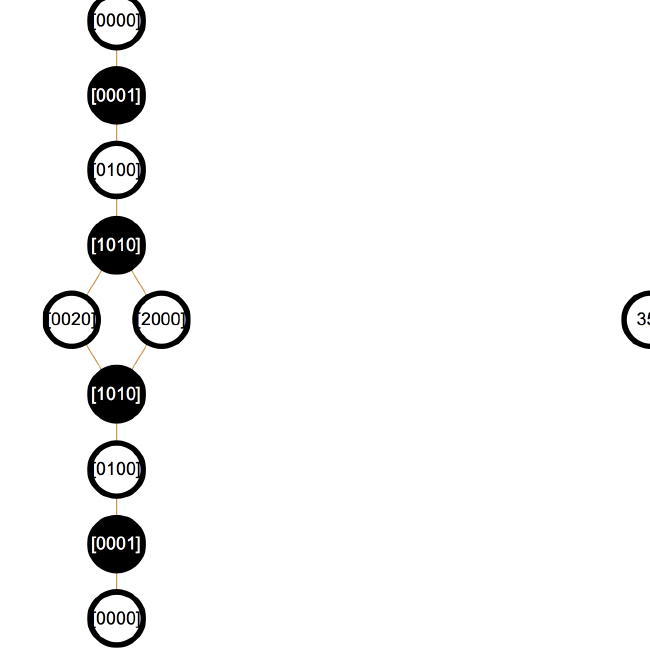
Figure 6 . Adinkra Diagram for 8D (1 , 0)